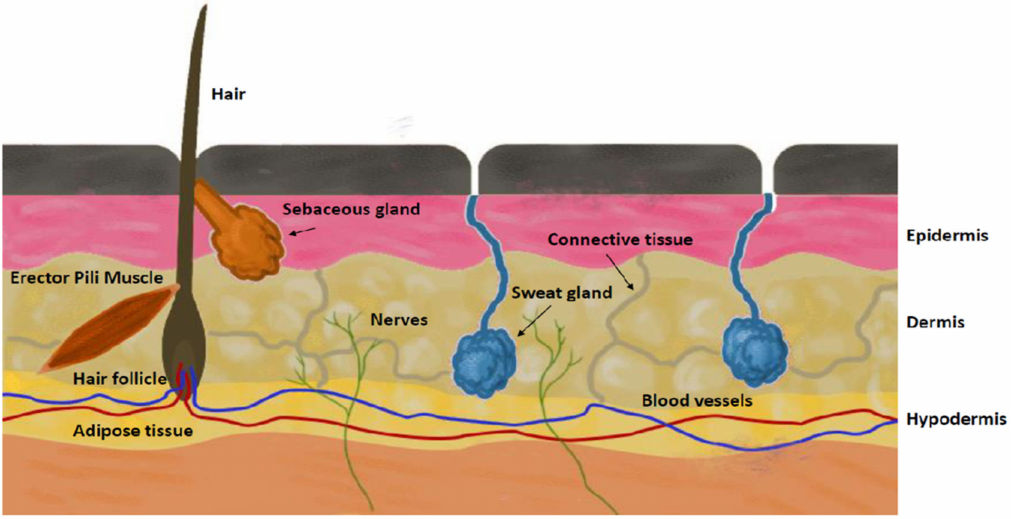
Figure 2. The anatomical structure of human